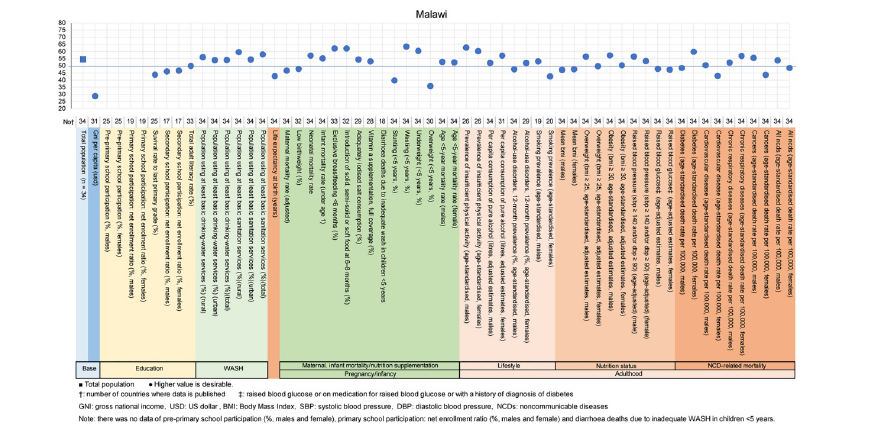
Fig 9. Country diagnosis by the deviation graph for Malawi.